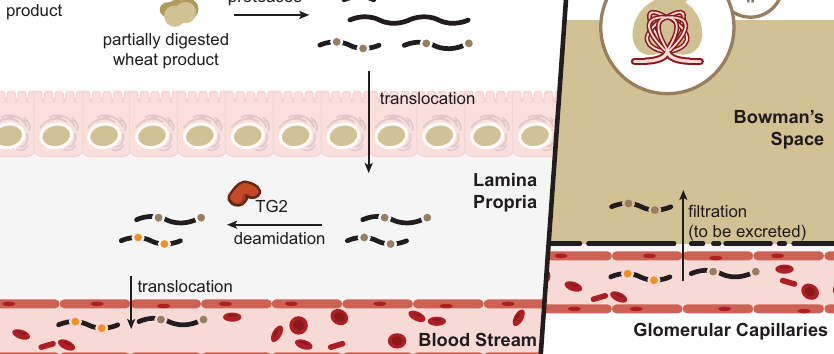
Fig. 6 Schematic representation of relevant metabolic products of dietary gluten in humans. Wheat-derived proteins such as gluten are resistant to gastrointestinal proteolysis. Incomplete digestion preserves disease-causing T-cell epitopes in peptides that accumulate in the gut lumen. A portion of these gluten peptides translocate to the lamina propria where transglutaminase 2 (TG2) deamidates selected Gln residues (brown dots) in some sequences, thereby converting them into Glu residues (yellow dots). Absorbed peptides can also enter the bloodstream, and are further metabolized and/ or excreted in urine.